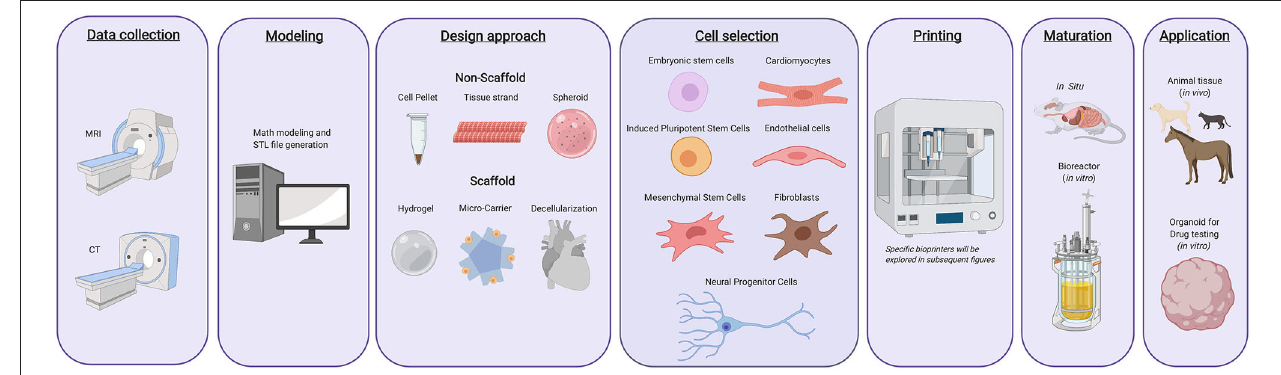
FIGURE 1 | Typical 3d bioprinting workflow. Tissues or organs are first imaged using a variety of techniques as to generate a guide that can be used while printing the desired constructs. The design approach is then selected, which includes biomimicry, self-assembly, or mini tissues. Materials and cells sources are then selected based on the desired tissue type, form, and function. Once these components have been selected, they are integrated into a bioprinting system and the 3D construct is generated. Following printing, the constructs can either be used immediately for in vitro purposes, in vivo transplantation, or can be matured further in a bioreactor before being utilized for other